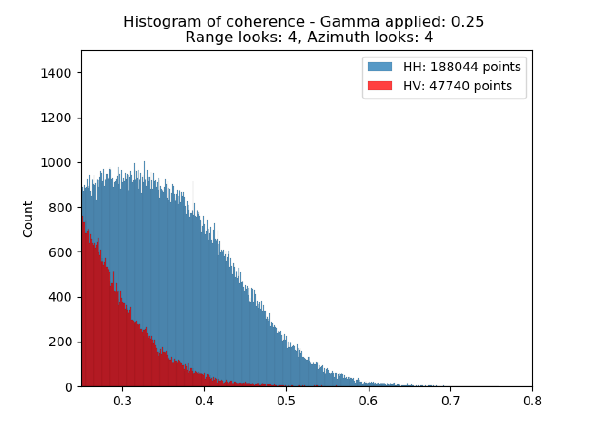
Figure 9. Histogram of coherence for the subsets of HH and HV of figure 8, after applying a γ threshold of 0.25.